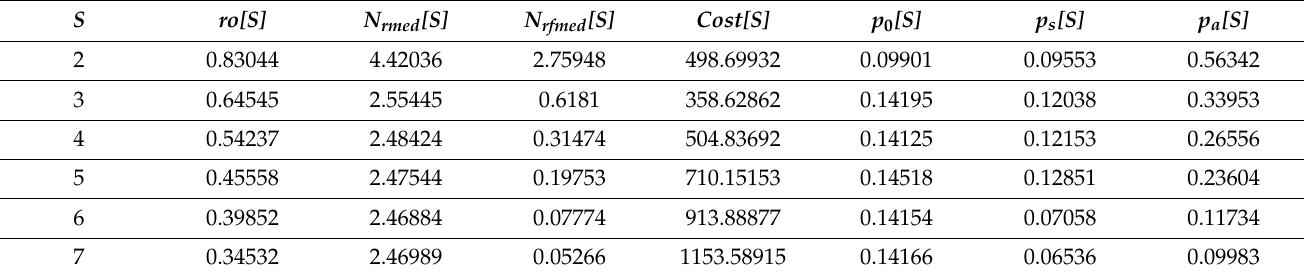
Table A3. The particular results.